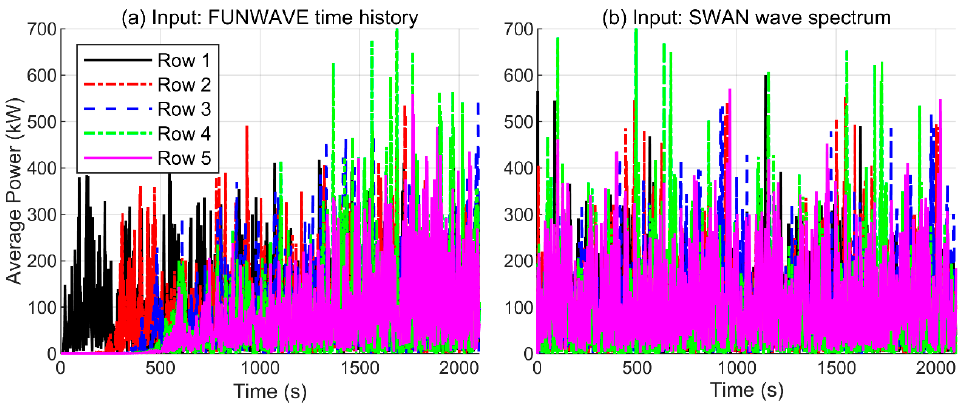
Figure 10. The transient average power of different rows of the WEC farm using ( a ) FUNWAVE time-histories and ( b ) SWAN wave spectra.